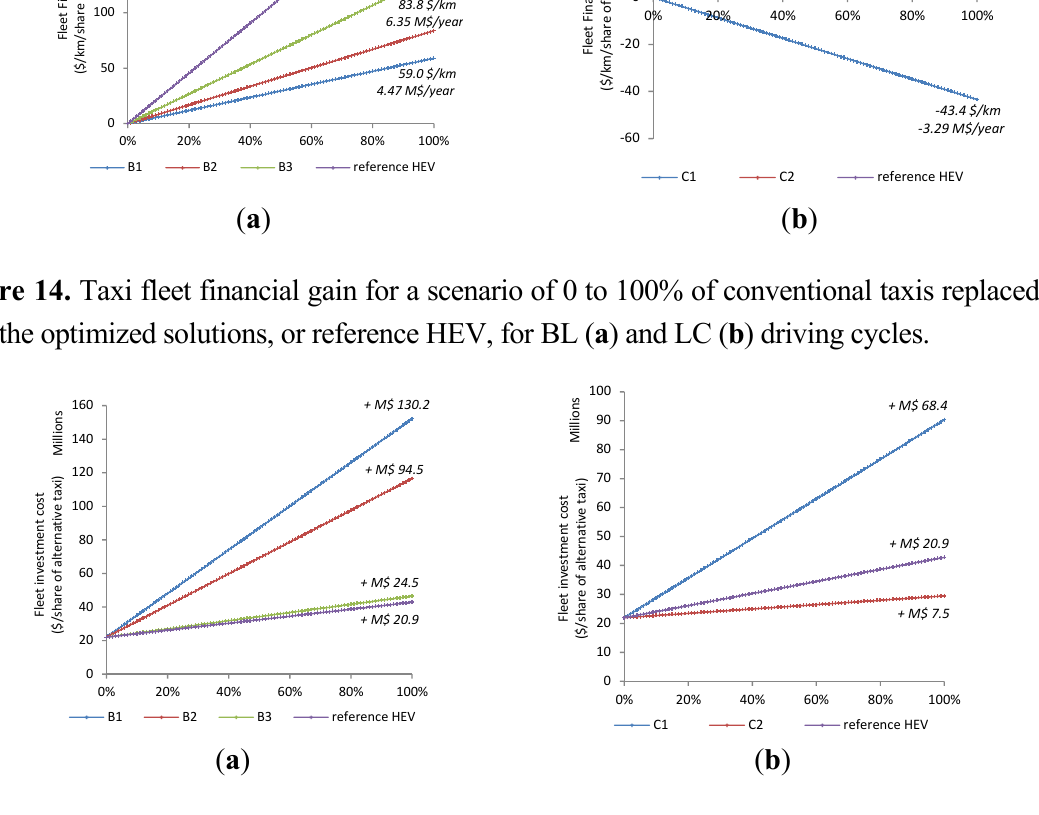
Figure 15. Taxi fleet investment cost for a scenario of 0 to 100% of conventional taxis replaced with the optimized solutions, or reference HEV, for BL ( a ) and LC ( b ) driving cycles.